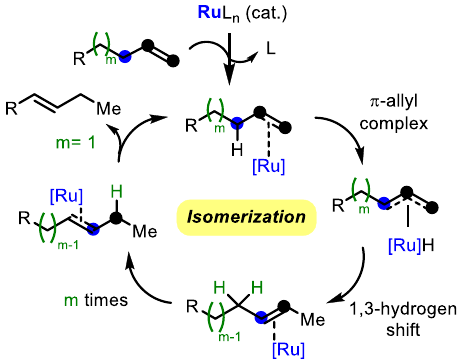
Fig. 6 Proposed reaction mechanism catalyzed by Ru (possibly Ru II ). The isomerization occurs m + 1 times along the chain until a more substituted position is found. Ru acts as a shuttle for the H atom and the alkene to move along the